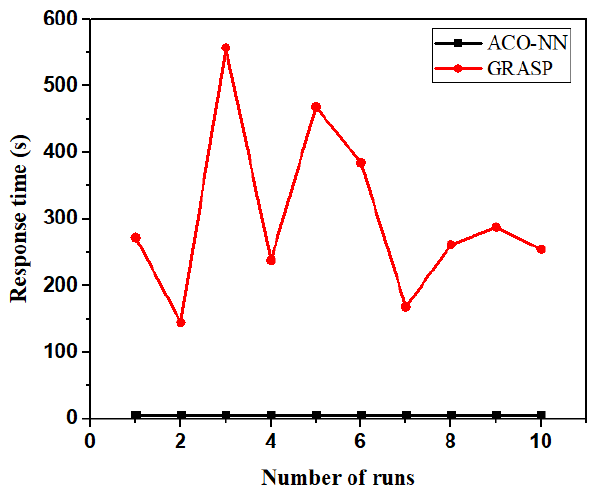
Figure 10. Comparison of ACO-NN with GRASP for St70 regarding response time metric.